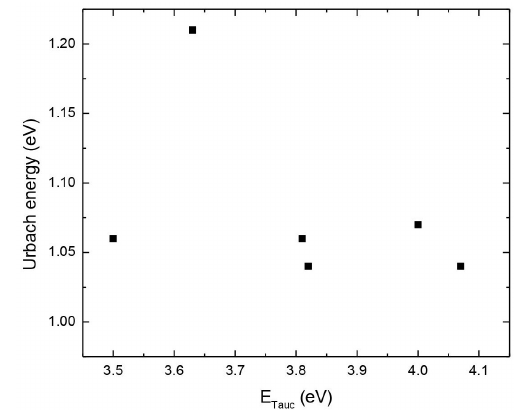
optical gaps as a function of R 04